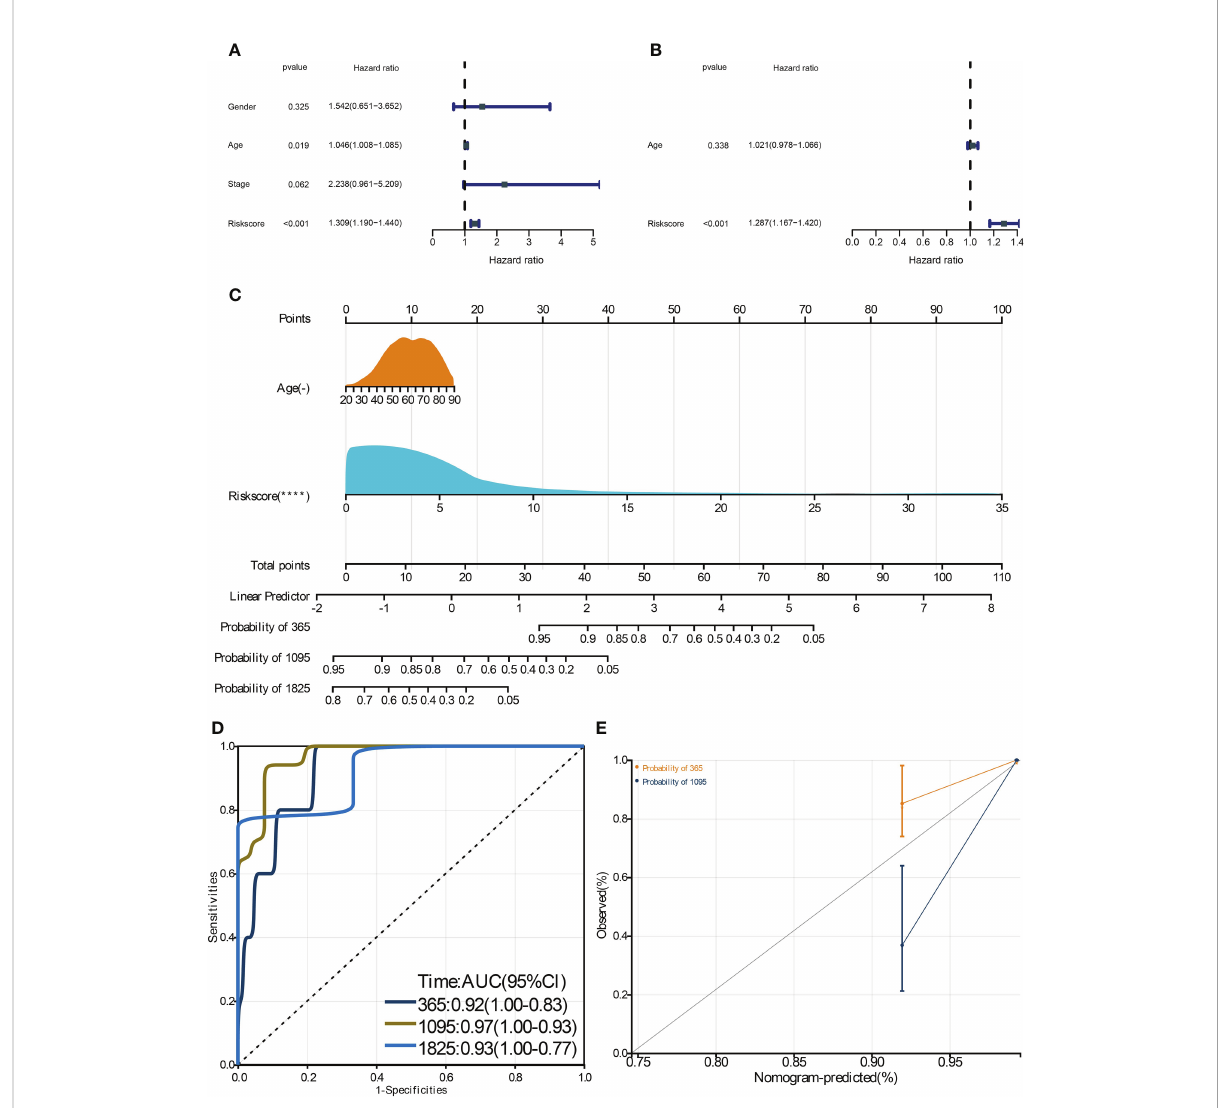
FIGURE 6 Construction and validation of a clinical nomogram. The univariate (A) and multivariate (B) Cox regression analysis to fi lter the prognostic predictors. C: The nomogram integrating the risk score and age to predict patient 1-, 3-, and 5-year survival. The ROC (D) and calibration curve (E) were used to evaluate the performances of the nomogram for predicting patient survival. **** means p-value <